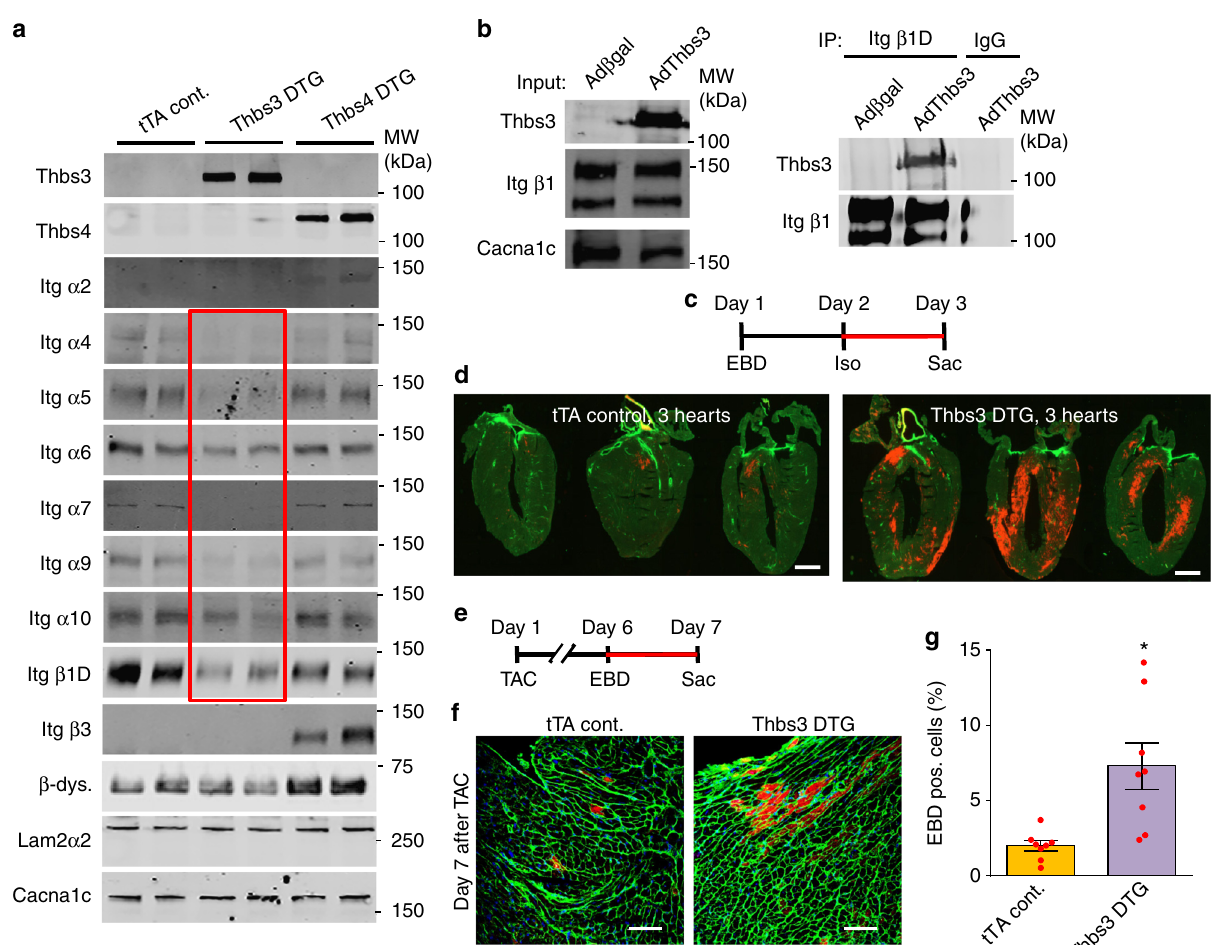
Fig. 3 Thbs3 reduces surface integrin levels and destabilizes the sarcolemma. a Representative Western blots of sarcolemma protein extracts from hearts of tTA control, Thbs3 DTG, and Thbs4 DTG mice, assayed for integrin proteins and β -dystroglycan. Laminin2 α 2 and Cacna1c serve as loading controls. Quantitation is shown in Supplementary Figure 3a-k. The red box shows integrin proteins speci fi cally reduced on the sarcolemma by Thbs3. b Western blots for input of microsomal protein extracts before immunoprecipitation for Thbs3 and β 1D integrin and Cacna1c from NRVMs infected with Ad β gal or AdThbs3 (left panel). The microsomal fraction was then immunoprecipitated (IP) for β 1 integrin and blotted for the indicated proteins (right panel). Mouse IgG was used as a control for the IP. c Regimen of Evans blue dye (EBD) and isoproterenol (Iso, 300 mg/kg) injection to measure membrane permeability in the hearts of mice. d Representative histological heart sections from 3 tTA control and 3 Thbs3 DTG mice, imaged for WGA (green fl uorescence) and leakage of EBD into the cardiomyocytes by red fl uorescence subjected to the experimental regimen shown in c . Scale bars are 1 mm. e Regimen of Evans blue dye (EBD) injection after TAC surgery to measure membrane permeability in adult mice. Mice were sacri fi ced (Sac) 24 h after EBD injection, 1 week after TAC surgery. f , g Representative cardiac histological images of tTA control and Thbs3 DTG hearts 1 week after TAC surgery stained with WGA (green) and intracellular leakage of EBD (red) according to the experimental scheme shown in e , while g shows quantitation of EBD positive cells in the hearts of these mice. Scale bars are 100 μ m. * P < 0.05 versus tTA control sham; two-tailed students T -test. Data are represented as percentage EBD positive cells ( ≥ 3000 cells from ≥ 8 animals). Error bars are + / − standard error of the mean and number of mice used is shown in the graph as